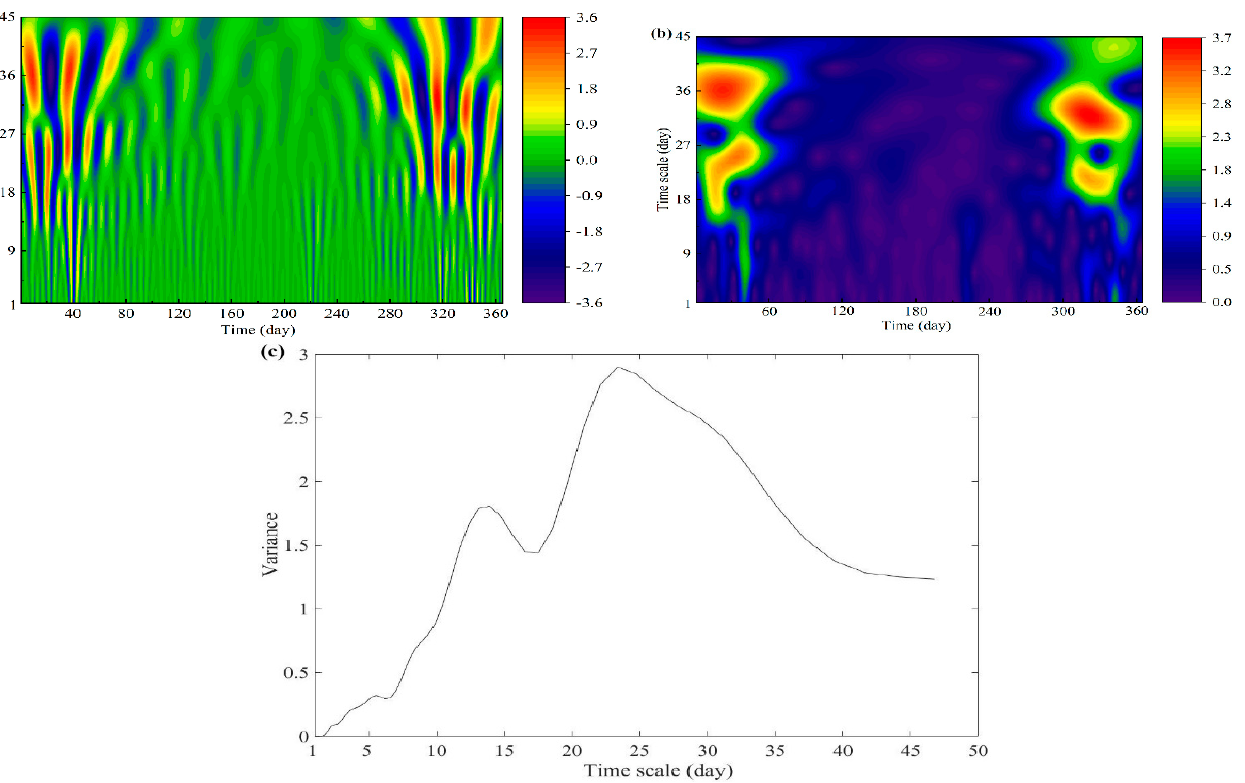
Figure 5. Wavelet coefficient diagram ( a ); wavelet energy diagram ( b ); wavelet variance diagram ( c